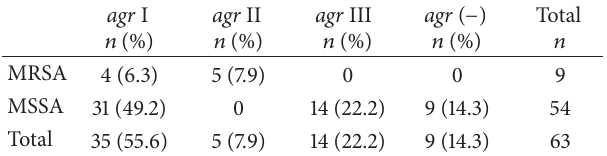
Table 4: Genetic polymorphism of the agr locus among MRSA and MSSA strains